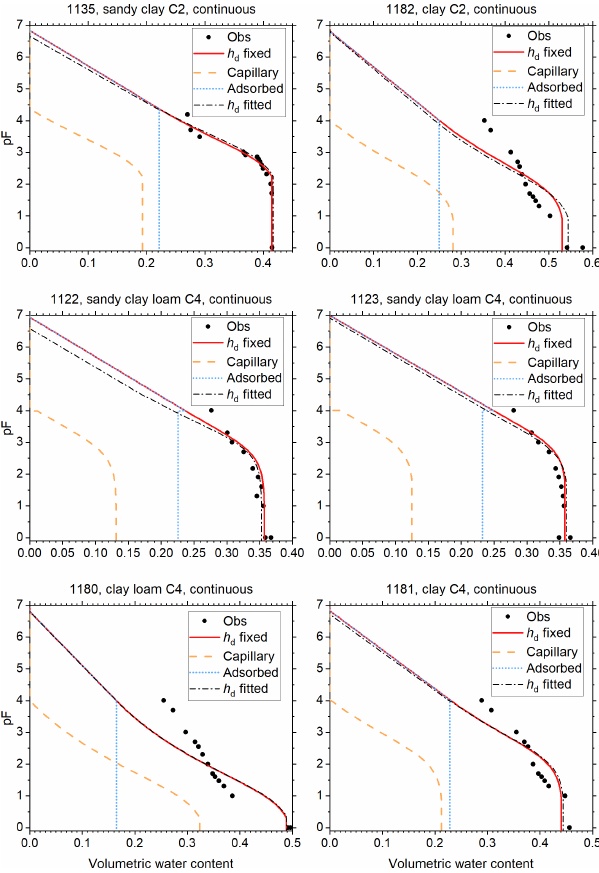
Figure 7. As Fig. 5, for soils of classes B2 and B4 of Twarakavi et al. (2010).